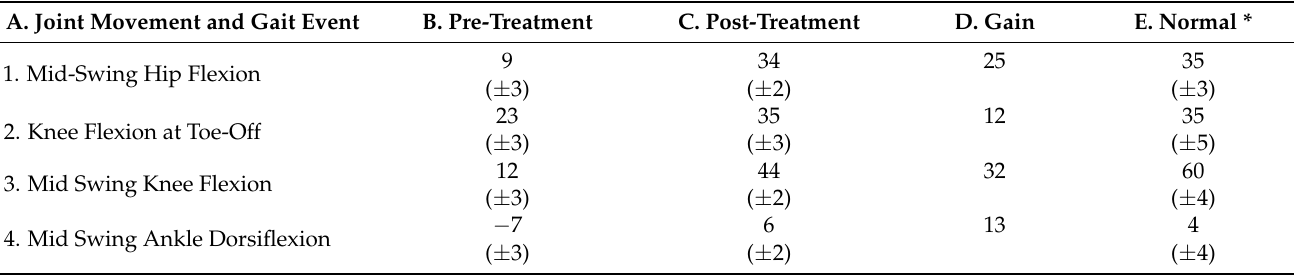
Figure 4. Change in Swing Phase Hip, Knee, and Ankle Flexion After Treatment. Panel ( A ). Pre- Treatment, Mid-Swing Gait Dyscoordination. At mid-swing, hip and knee flexion are absent, and the ankle is slightly plantar-flexed. The right plantar surface is sliding across the floor in order to bring the right limb at least up to the left stance limb. Panel ( B ). Post-Treatment, Mid-Swing Improved Hip, Knee, and Ankle Flexion. At mid-swing, the right hip, knee, and ankle are flexed, which is necessary in order for the right limb to clear the floor during swing phase (with permission, Stroke 2006, Daly et al. [47]). Table 3. Gait Kinematic Improvements (degrees of